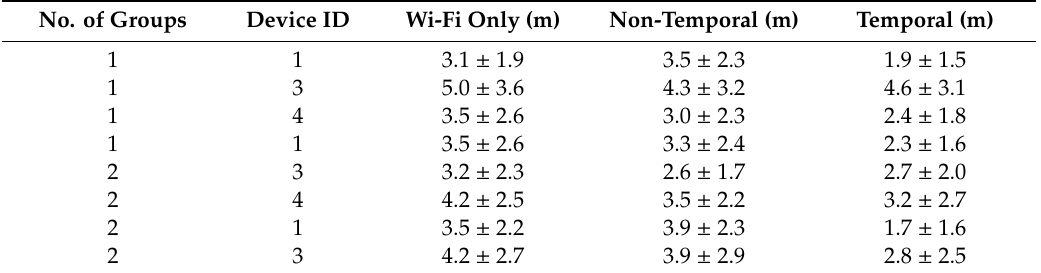
Table 7. Average positioning errors per device for four-user